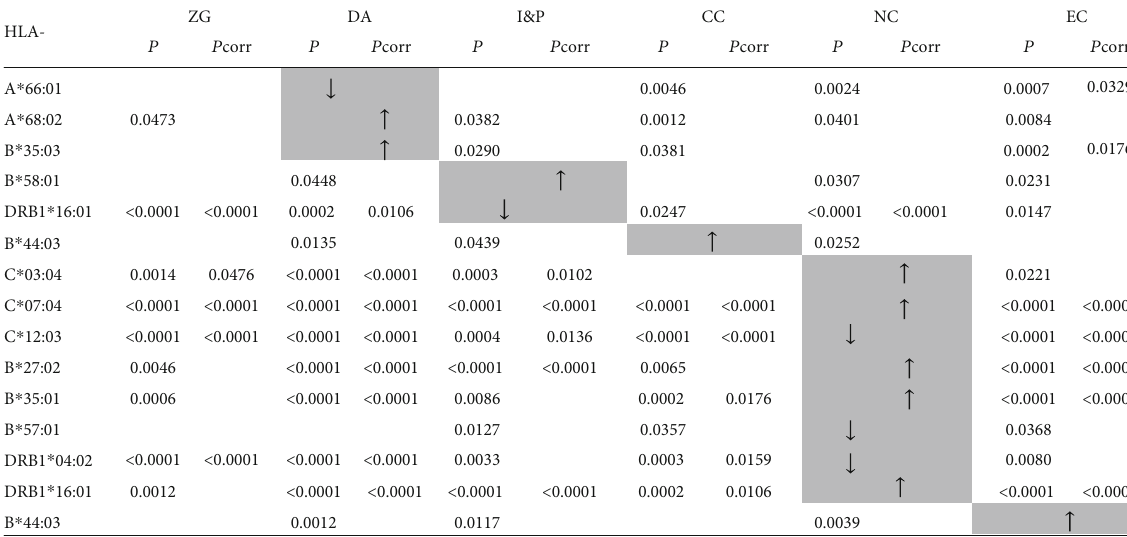
Figure 2: The list of HLA-A, -C, -B, and -DRB1 alleles which demonstrated a signi fi cantly di ff erent frequency in one region in comparison to at least three other regions. Legend: ZG: Zagreb; DA: Dalmatia; I&P: Istria & Primorje; CC: Central Croatia; NC: North Croatia; EC: East Croatia; P corr: corrected P value by the number of alleles observed at each locus; ↑ / ↓ : frequency signi fi cantly higher/lower than in at least three other regions; grey-shaded box: region di ff ering in allele frequency from at least three other